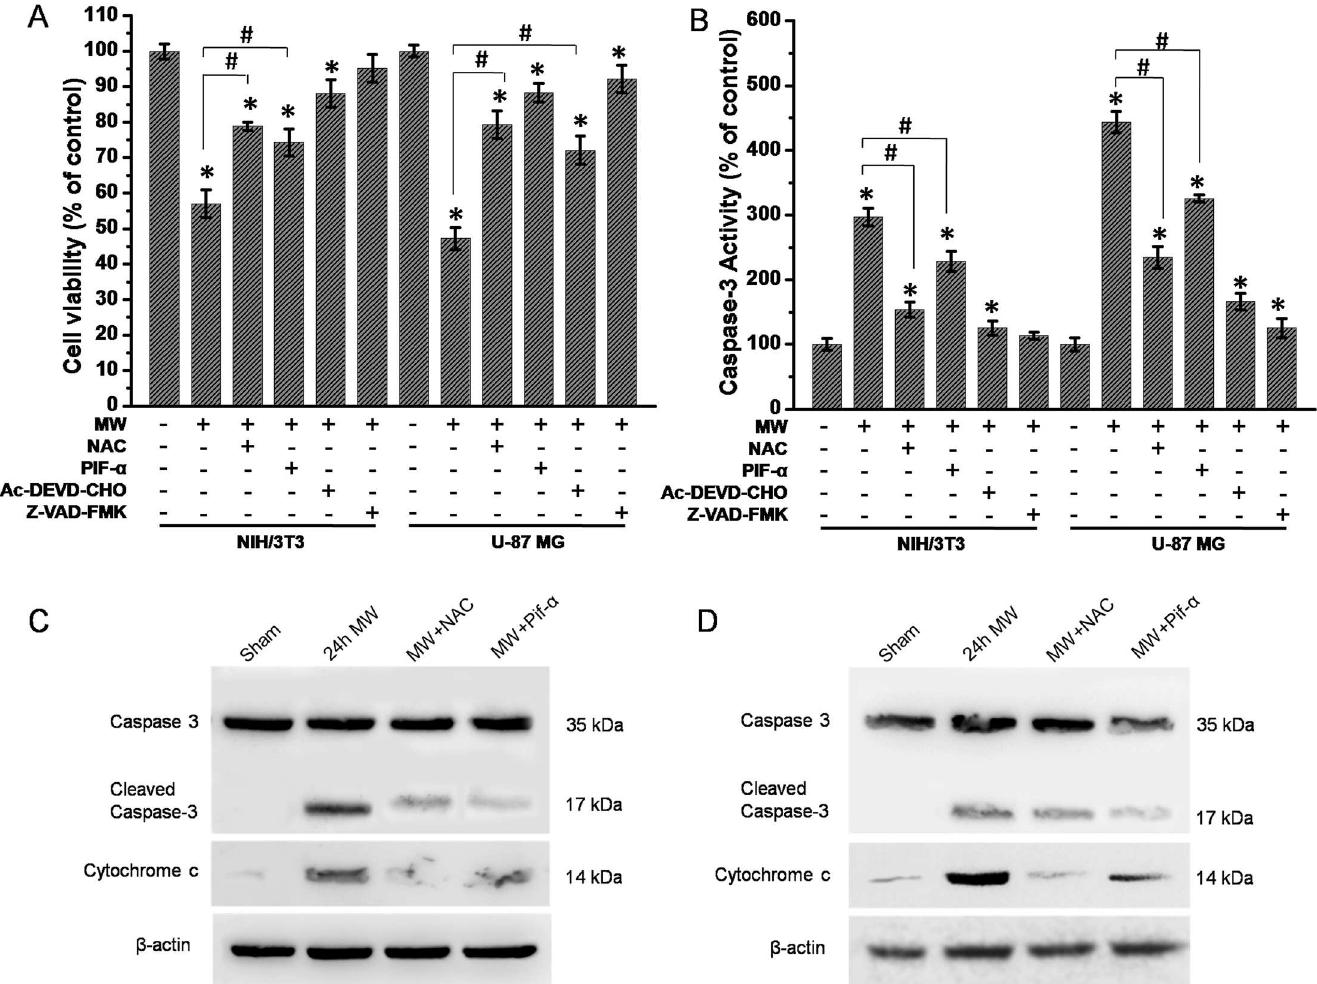
Fig 6. ROS and p53 involve in cytochrome c -mediated caspase-3 activation during 1800MHzmicrowave-induced cell apoptosis. (A, B) Effects of NAC, PIF- α , Ac-DEVD-CHO and Z-VAD-FMK on cell viability and caspase-3activity after 1800MHzmicrowave radiation for 24 hours in NIH/3T3 and U-87 MG cells. Cells were pretreated with treatments (NAC, PIF- α , Ac-DEVD-CHO and Z-VAD-FMK) for 20 min and then exposed to 1800MHz microwave or sham treatment for 24 hours. After microwave radiation, cells were harvestedand levels of cell viability and caspase-3 activity were measuredin NIH/3T3 and U-87 MG cells. Cell CountingKit-8 (CCK-8, DojindoLaboratories, Kumamoto, Japan) was used to evaluate cell viability after various treatments. Caspase-3activity was measured by the caspase-3 activity kit. (C, D) Western blotting analysisof caspase-3 activation and cytochrome c release from mitochondria to cytoplasm. Cells were pretreated with or without NAC and PIF- α for 20 min before exposure to 1800MHz microwave. After microwave radiationfor 24 hours, cells were harvestedand measured protein levels of caspase-3. The cytoplasm proteins were extracted using a mitochondria/cytoplasm fractionationkit followedby western blotting analysisof cytochrome c in cytoplasm. MW, microwave; NAC, N- acetyl-L-cysteine. PIF- α , pifithrin- α . All the data in these figures are presentedas mean ± S.D. (n = 3; * P < 0.05 vs. control group; #P < 0.05 indicated